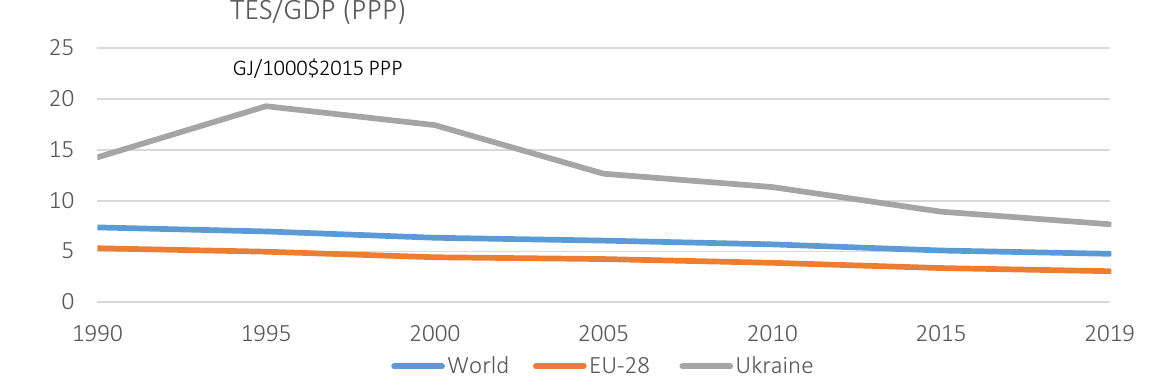
Figure 6. Total energy supply by GDP (PPP)